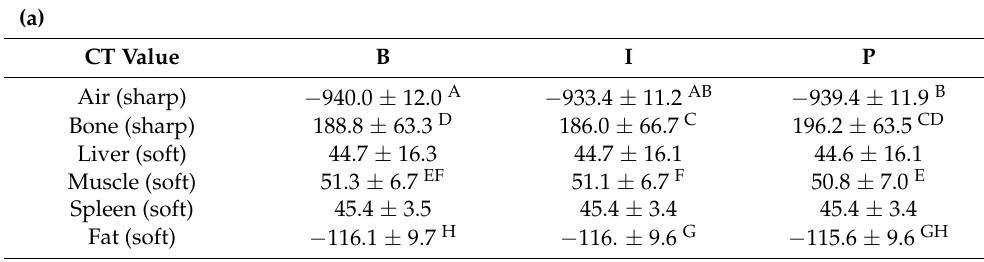
Table 4. Results of the CT value measurements and statistical analysis in the regions-of-interest liver, spleen, muscle, fat (soft kernels) and in the air and lung (sharp kernels). CT values of the three evaluated reconstructions were compared (B vs. I, I vs. P, P vs. B). Differences between CT values with shared superscripts were statistically significant.